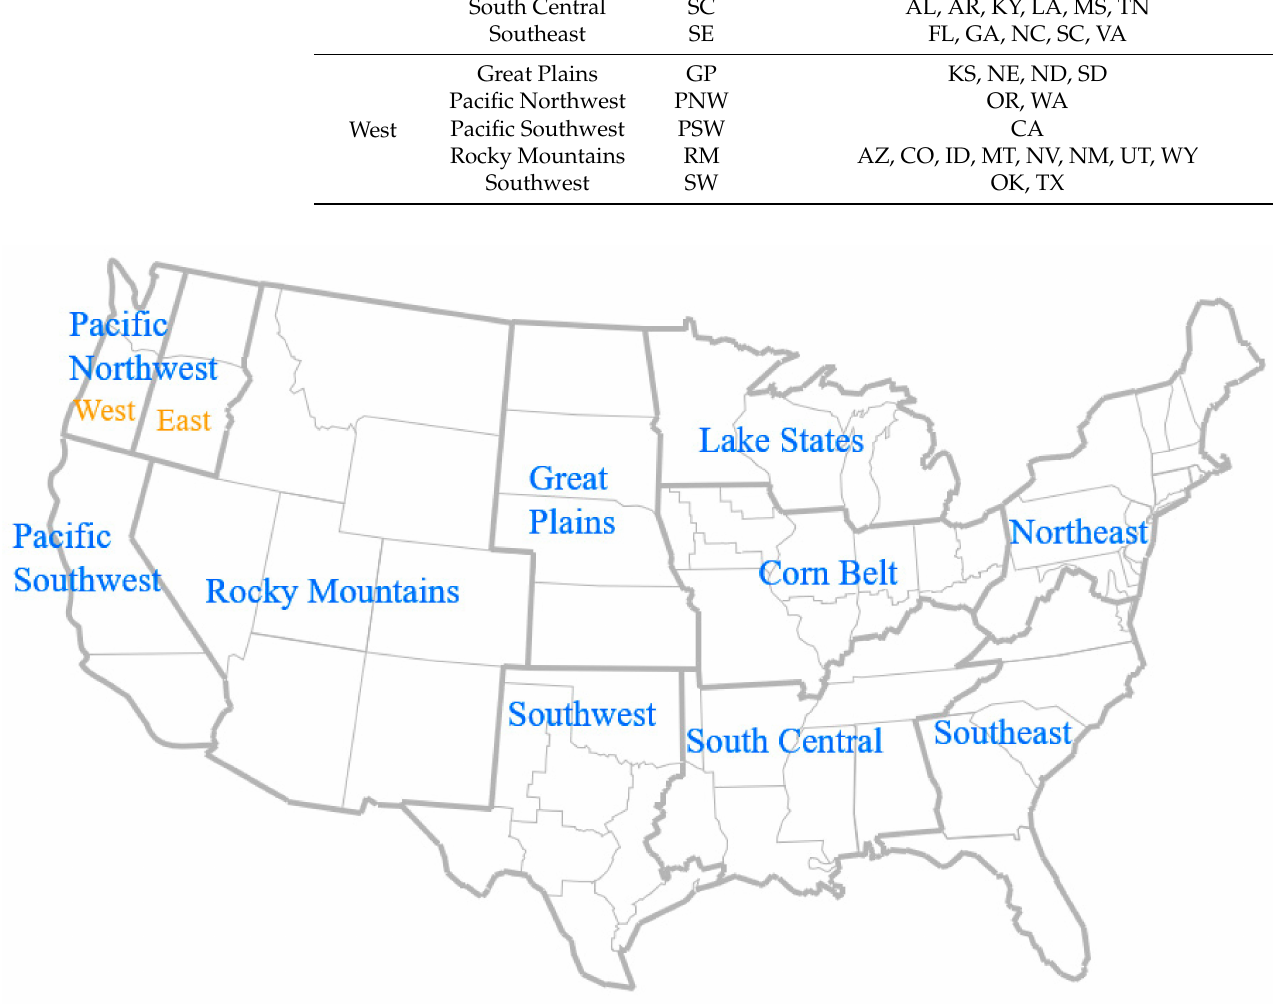
Figure 1. Map of US market regions used in fixed effects. Source: Adams et al.